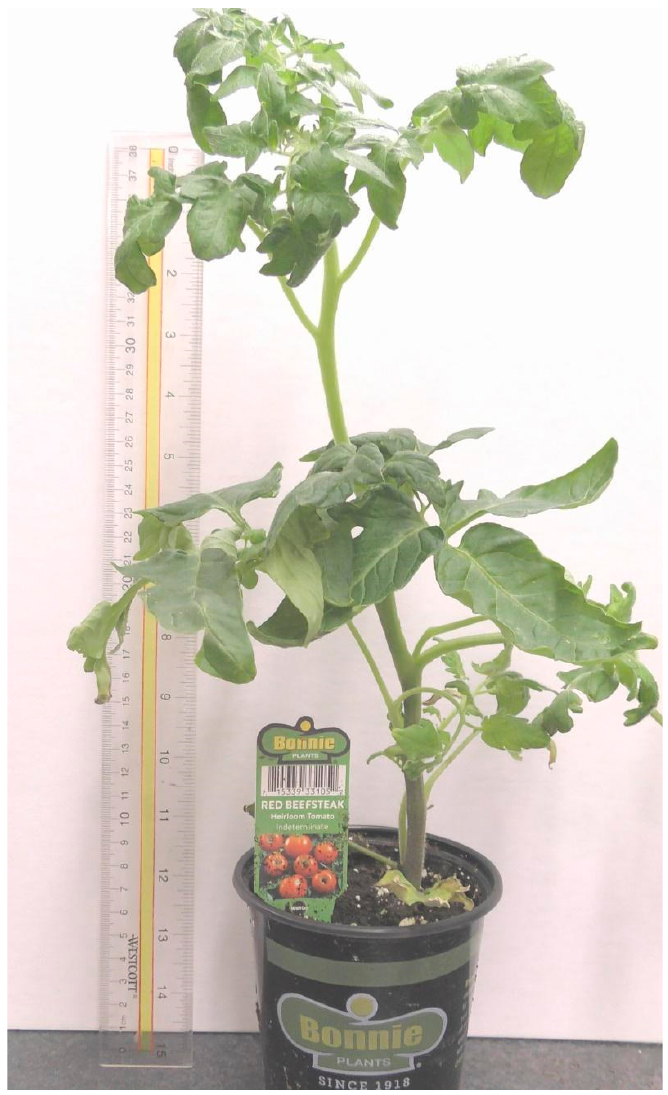
Figure A1. Red Beefsteak Tomato.